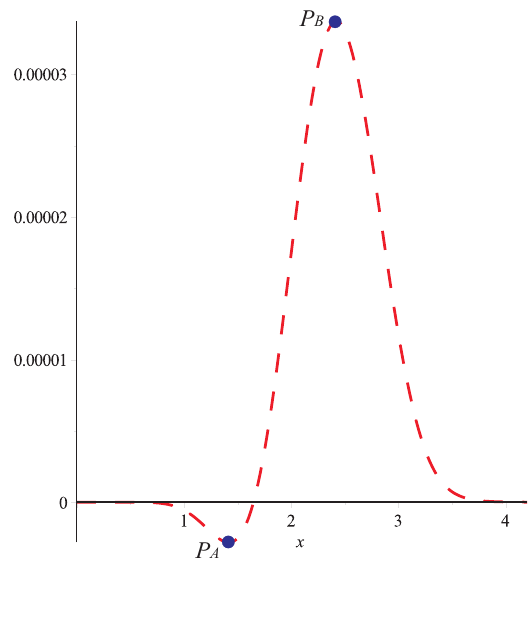
Figure 12: Relative error of (40)